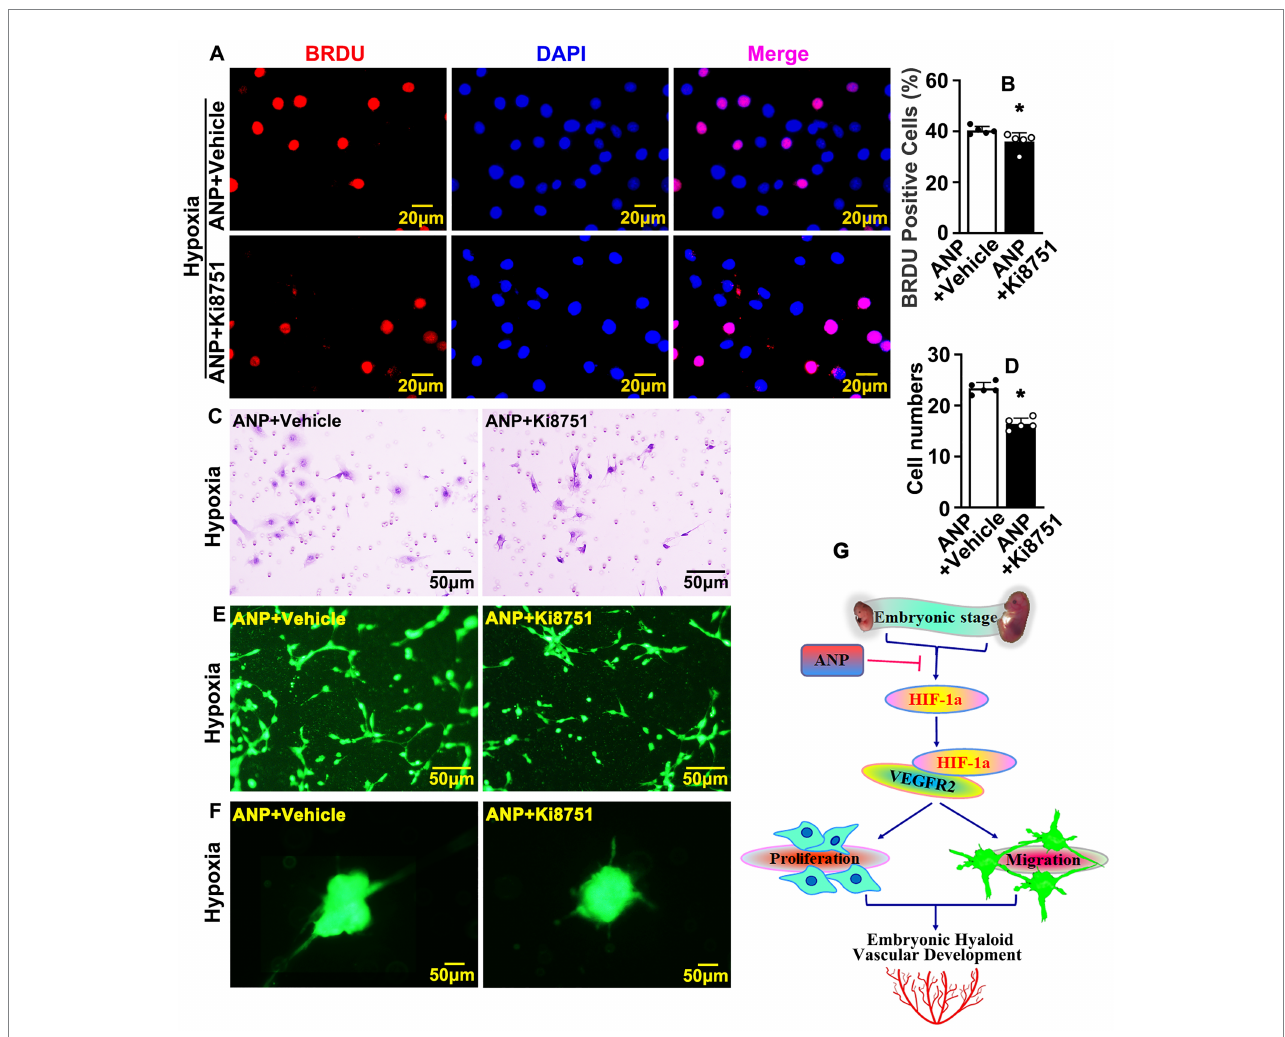
FIGURE 7 Interruption VEGF receptors further suppresses andrographolide mediated embryonic hyaloid vasculature development. (A) Hypoxia conditions were induced in HUVEC-C by 200 μ M CoCl 2 treatment and VEGFR2 inhibition performed by Ki8751 treatment (Ki8751, a VEGFR2 inhibitor). Following BrdU labeling reagent labeled for 24 h after treatment of andrographolide. Immunofluorescence staining was performed to determine BrdU incorporation. (B) The quantification of BrdU positive cells from (A) ( n = 5). (C) Boyden chamber cell migration assay was performed to validate the role of VEGFR2 on cell migration after VEGFR2 inhibition following andrographolide under hypoxia conditions. (D) The quantification of migrated HUVEC-C from (C) ( n = 5). (E) Matrigel-based tube formation assay was performed to validate the role of VEGFR2 on tube formation after VEGFR2 inhibition with andrographolide treatment under hypoxia conditions. (F) Spheroid sprouting assay was performed to validate the role of VEGFR2 after VEGFR2 inhibition with andrographolide treatment under hypoxia conditions. (G) The schematic diagram indicates how andrographolide regulates embryonic hyaloid vascular